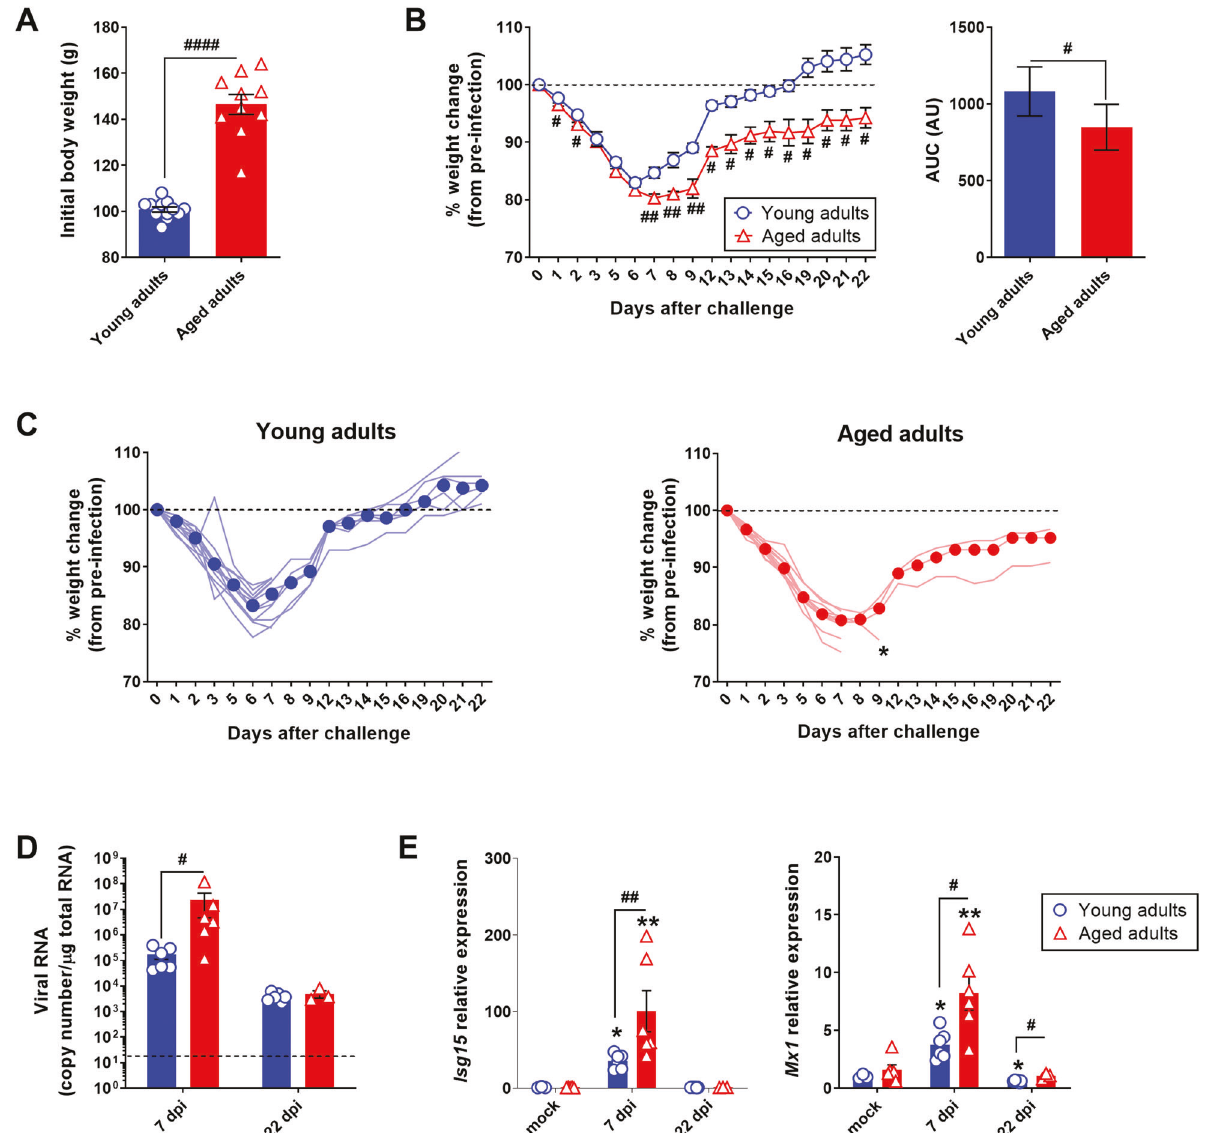
Fig. 1 SARS-CoV-2 infection is more severe in aged golden hamsters. Golden (Syrian) hamsters aged 2 months (the “ young adults ” group) or 22 months (the “ aged adults ” group) were treated intranasally with a SARS-CoV-2 inoculate ( n = 12 young adults and n = 10 aged adults) or with DMEM (mock infection) ( n = 6 young adults and n = 6 aged adults). A Body weight (g) on the day of infection. Data are expressed as the mean ± SEM, and individual replicates are shown ( n = 12 young adults and n = 10 aged adults). B Percentage body weight change after infection (left). Data are expressed as the mean ± SEM ( n = 12 young adults and n = 10 aged adults). The corresponding area under the curve (AUC) is shown (right). Data are expressed in arbitrary units (AU). C Percentage body weight change after infection in individual animals. Median weight losses are depicted as plain circles. Asterisks indicate death. D Quanti fi cation of SARS-CoV-2 RNA in the lungs of young adult and aged adult hamsters, using an RT-qPCR assay. Viral RNA levels are expressed as the mean ± SEM copy number/ μ g of total RNA, and individual replicates are shown (mock and 7 days post infection (dpi): n = 6 animals per group, 22 dpi: n = 6 young adults and n = 3 aged adults). The dashed line represents the assay ’ s limit of detection. E mRNA expression levels (RT-qPCR assay) of the Isg15 and Mx1 genes in the lungs of young adult and aged adult hamsters, presented according to the 2 − ΔΔ CT method (housekeeping gene: Actg1 , coding for gamma ( γ ) actin). Data are expressed as the mean ± SEM, and individual replicates are shown (mock and 7 dpi: n = 6 animals per group, 22 dpi: n = 6 young adults and n = 3 aged adults). Groups were compared in a two-sided Mann – Whitney test; # indicates the P values for the comparison of young adults and aged adults (the effect of age: # P < 0.05, ## P < 0.01 and #### P < 0.0001), and * indicates the P values for the comparison of mock-treated and SARS-CoV-2-infected groups (the effect of infection: * P < 0.05 and ** P < 0.01). For intergroup differences, the threshold for statistical signi fi cance was set to P < 0.05. young adult and aged hamsters; this effect was especially samples (Supplementary Fig. S3B). These results show that in the maintained at 22 dpi in the latter group (Tables 1 and 2 and golden hamster, aging per se affects adipocyte lipid metabolism Fig. 3A). In SCAT, the decrease in adipocyte size induced by and triggers in fl ammation (a phenomenon known as in fl amma- SARS-CoV-2 infection at 7 dpi was similar in young adult and ging [45 – 48]) in the SCAT but not in the VAT. aged hamsters (a 49% decrease vs. mock for young adults, Importantly, SARS-CoV-2 infection induced a marked P < 0.0001, and a 42% decrease for aged adults, P < 0.0001). decrease in mean adipocyte size in the SCAT and VAT of both Cell Death and Disease (2023)